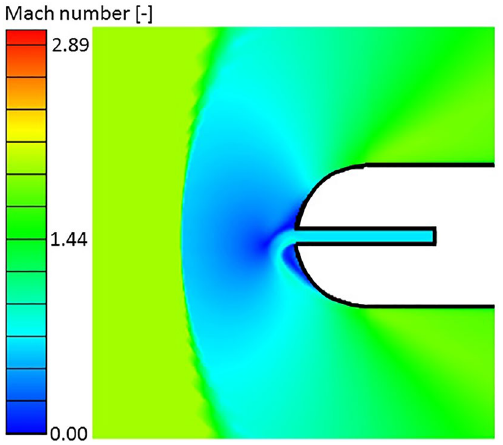
Figure 14. Leading edge region Mach contour with Coanda effect flow topology due to cooling